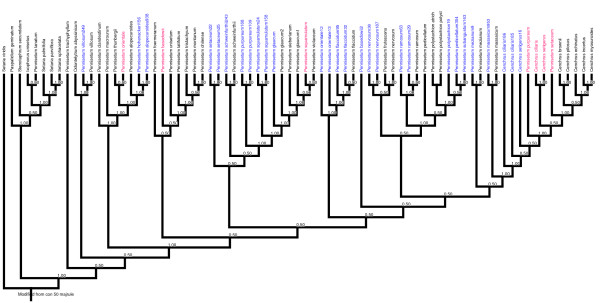
Comparative Bayesian tree. Bayesian tree based on ndhF+trnLF sequence alignments generated from combined analysis of sequence matrix generated in present study and Chemisquy et al. [26].